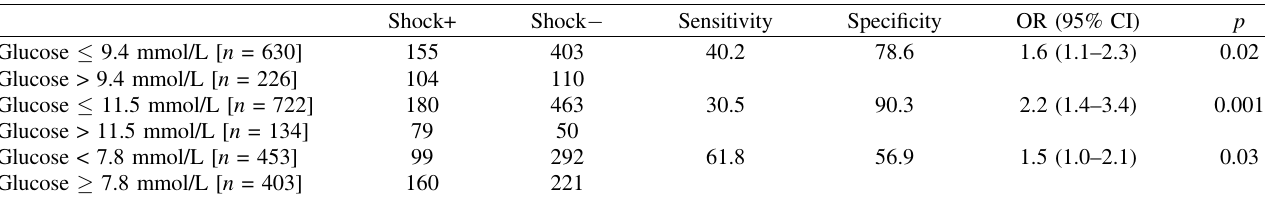
Table 3. Different cut off values of admission blood glucose with corresponding odds ratio (OR) and 95% con fi dence interval (95% CI) for predicting shock at admission in multiply injured patients with sensitivity and speci fi city. Shock+ Shock (cid:4)